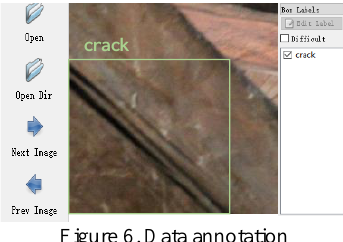
Figure 3. DarkNet-53 Structure